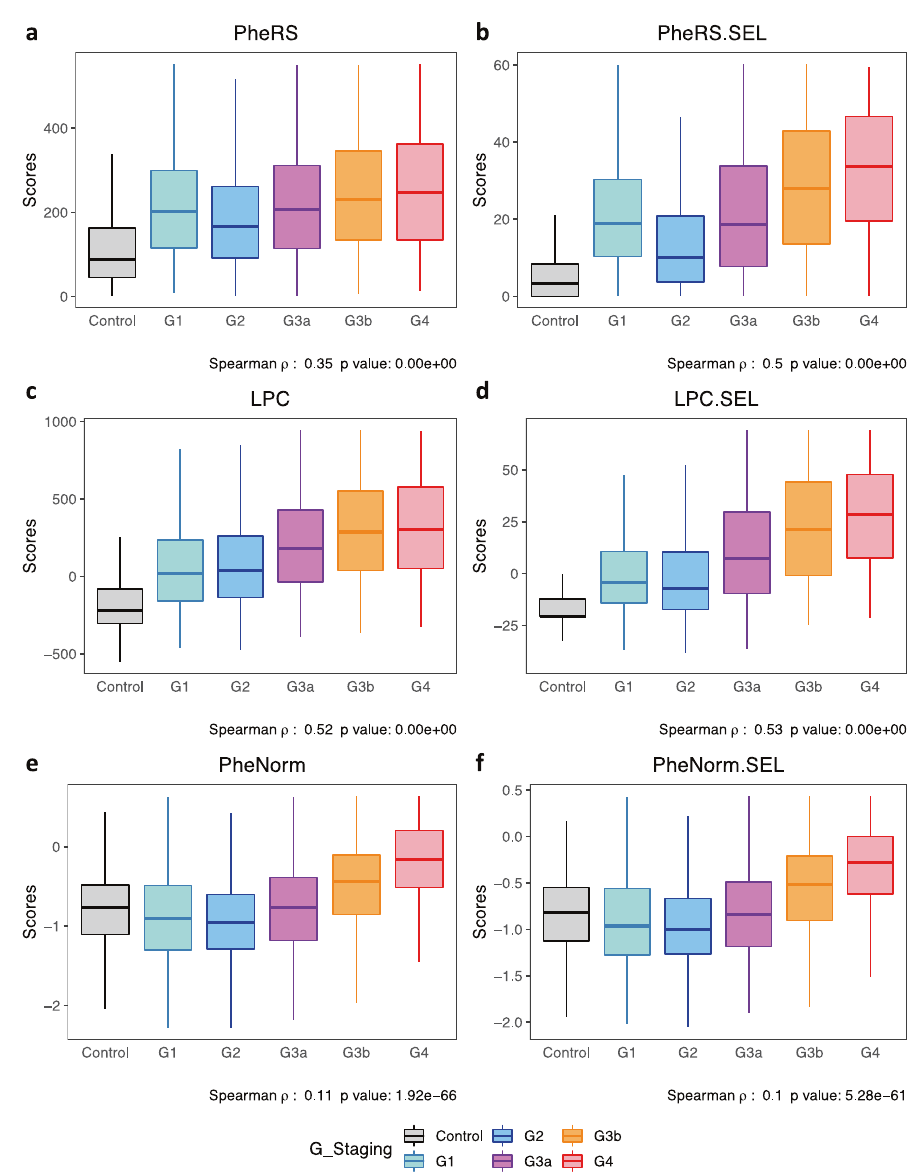
Fig. 2 Quantitative disease risk scores vs. CKD G-staging. Boxplots of quantitative disease risk scores a PheRS, b PheRS.SEL, c LPC, d LPC.SEL, e PheNorm, and f PheNorm.SEL. Quantitative disease risk scores are derived based on all phecodes (PheRS, LPC, PheNorm), or 110 pre- selected CKD feature phecodes (PheRS.SEL, LPC.SEL, and PheNorm.SEL). The center line, lower and upper bounds of the box represent the median, fi rst quartile ( Q 1 , or 25th percentile), and third quartile ( Q 3 , or 75th percentile) of the data, respectively. The whisker is drawn up (down) to the largest (smallest) observed point from the data that falls within 1.5 times the interquartile range ( = Q 3 − Q 1 ) above (below) the Q 3 ( Q 1 PheNorm: 0.813 vs. 0.718 vs. 0.523 for CKD, 0.876 vs. 0.784 vs. 0.817 de fi ned (soft) labels (e.g., based on presence of eGFR slope for CAD, 0.688 vs. 0.634 vs. 0.776 for T2D, 0.872 vs. 0.745 vs. 0.937 for measurement for CKD, or a phecode of the target phenotype) are HF, 0.765 vs. 0.659 vs. 0.762 for Dementia, and 0.844 vs. 0.813 vs. suf fi cient for training. 0.805 for GERD (Fig. 1). Although PheNorm seems to perform better We compared PheRS, PheNorm, and LPC scores using either all for T2D and HF, it is important to note that PheNorm uses the case phecodes or the pre-selected phecodes in terms of area under the de fi ning phecodes in the training stage whereas they are not receiver operating characteristic curve (AUROC) and the area under included in the LPC and PheRS calculations for these prediction the precision-recall curve (AUPRC) in the test datasets. Note that the accuracy assessments. LPC also has the largest AUPRC for CKD, CAD, labels used in the performance evaluation are derived using and GERD (Supplementary Fig. 1). LPC with pre-selected phecodes algorithms available in PheKB rather than gold-standard labels from exhibits the largest AUROC for all phenotypes except for HF when chart review. We acknowledge this limitation to the results we compared with PheRS and PheNorm: 0.779 vs. 0.772 vs. 0.522 for present due to the current limited availability of such gold-standard CKD, 0.927 vs. 0.917 vs. 0.702 for CAD, 0.764 vs. 0.749 vs. 0.760 for labels for the diseases we considered. We observed that LPC with all phecodes has the largest AUROC for CKD, CAD, Dementia and GERD, and the second largest for T2D and HF compared with PheRS and